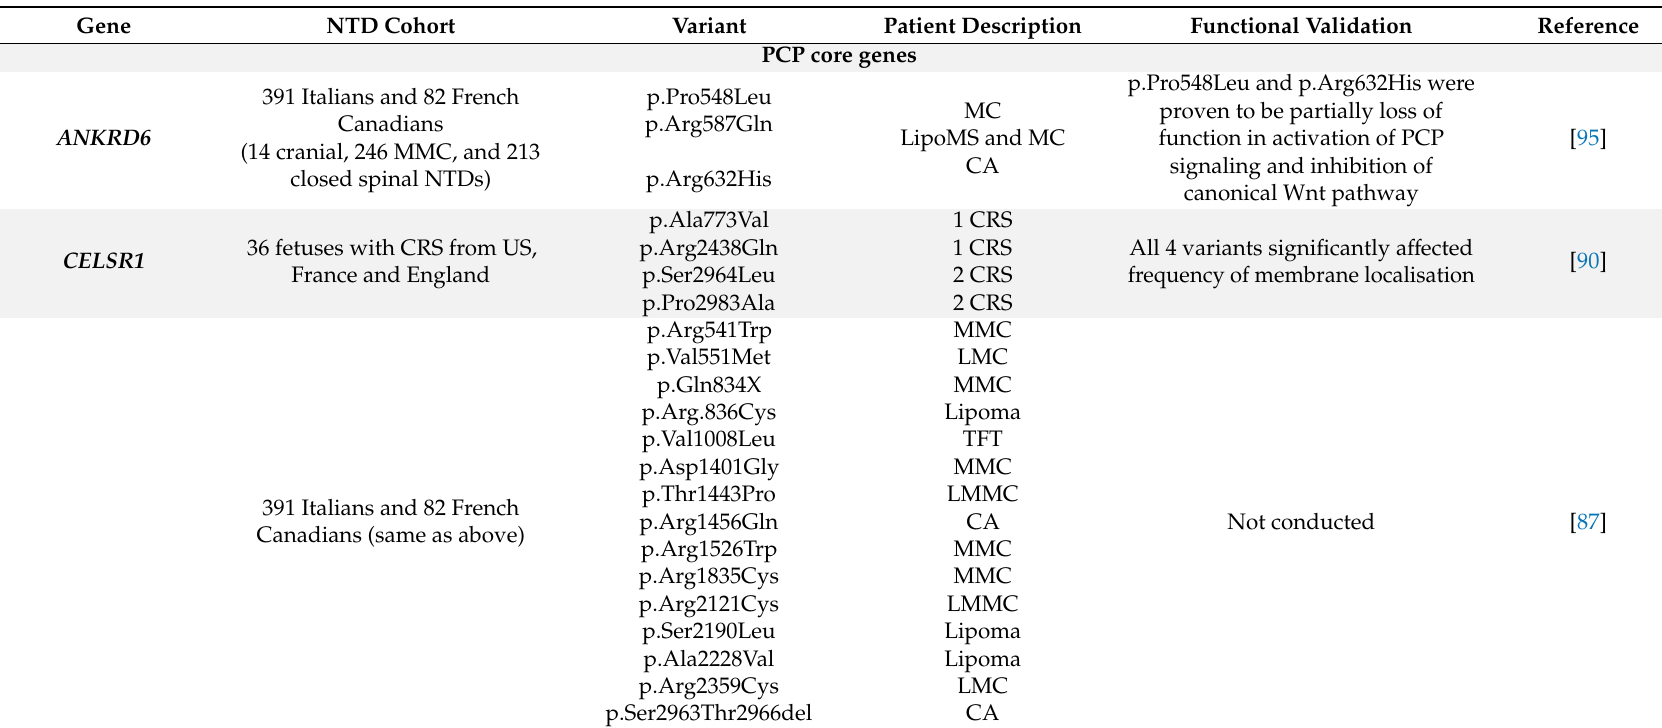
Table 1. List of rare coding PCP variants identified in neural tube defects (NTDs) and predicted to be damaging and / or a ff ect protein function in